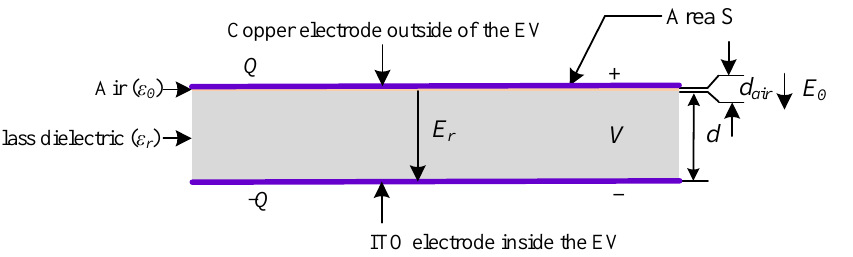
Figure 6. Structure of capacitor with glass dielectric layer.